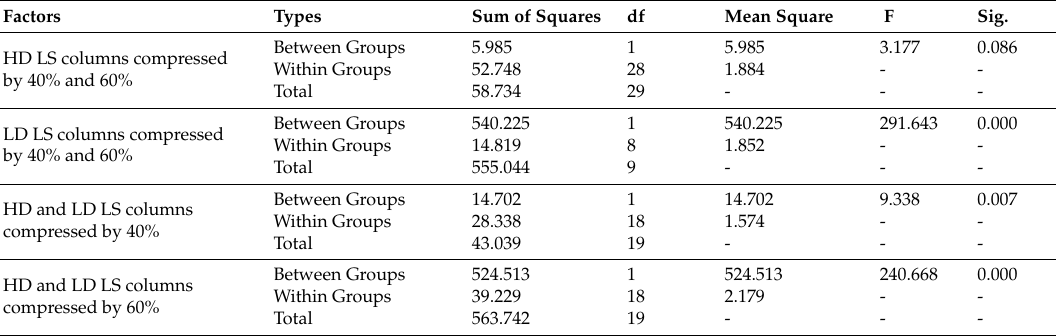
Table 3. Analysis of Variance (ANOVA) of height recovery of LS